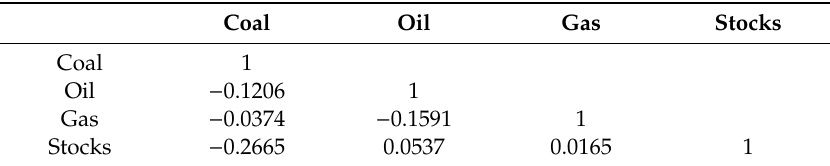
Table 22. Correlations for Hong